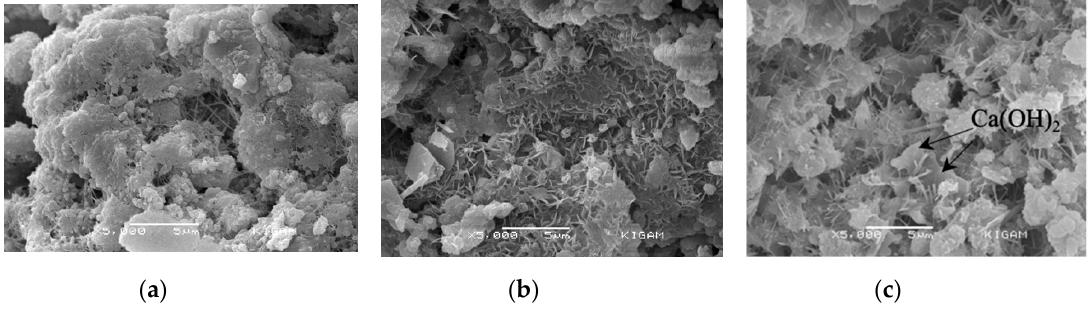
Figure 7. SEM images of ( a ) SC100, ( b ) SC80RM20, and ( c ) SC80NTRM20 on the first day.